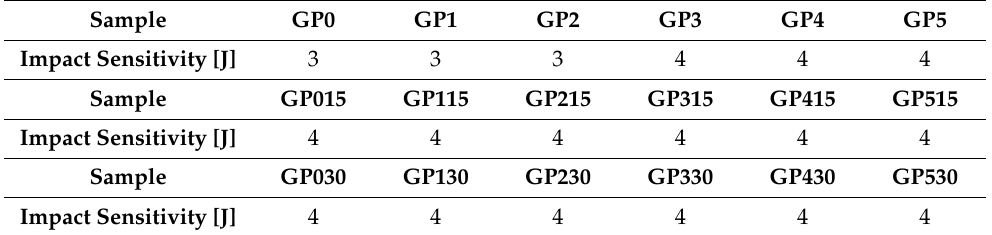
Table 10. Mechanical sensitivity to impact stimuli of “green” formulations.